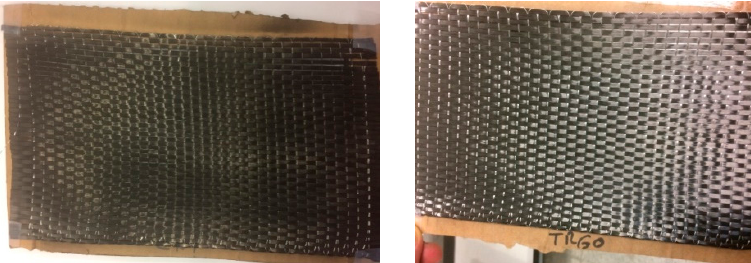
Figure 1. Surface modified carbon fiber by spraying of carbon nanoparticles: multi-walled carbon nanotubes (MWCNTs, left) and thermally reduced graphene oxide (TRGO, right).